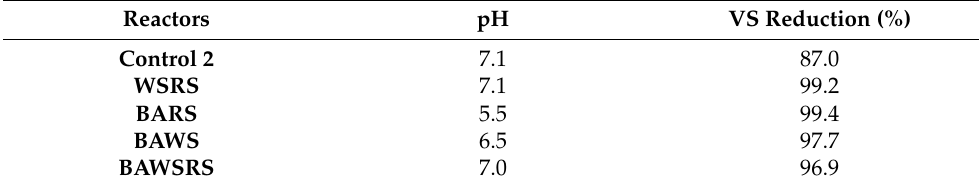
Table 3. pH and VS Reduction % after Co-digestion of S/I Ratio